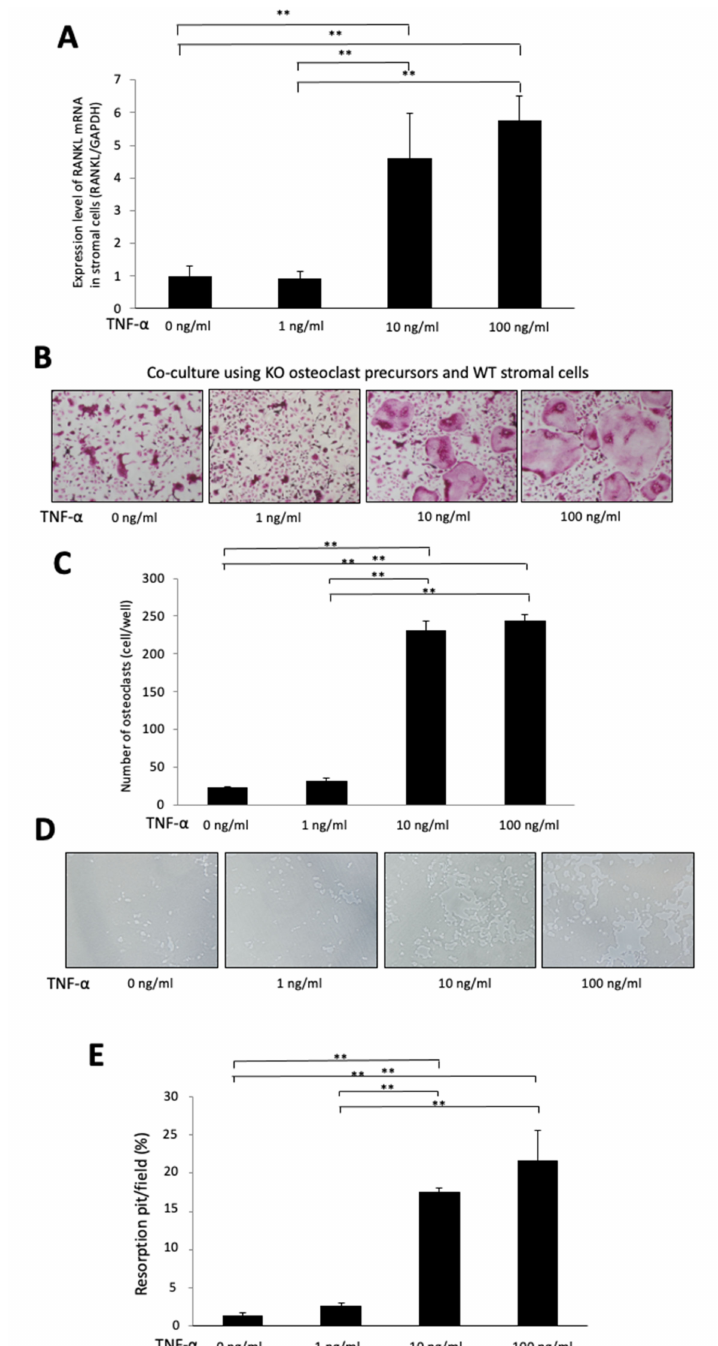
Figure 6. TNF- α induces RANKL expression in WT stromal cells and induced osteoclast formation in a co-culture using KO osteoclast precursors to eliminate the effect of TNF- α on osteoclast formation and WT stromal cells in a dose-dependent manner: ( A ) Real-time RT-PCR analysis of expression levels of RANKL mRNA in WT stromal cells. Total RNA was obtained from WT stromal cells cultured with TNF- α (0, 1, 10 and 100 ng/mL) for 3 days. ( B ) Images of TRAP-positive cells and ( C ) the number of TRAP-positive cells. ( D ) Images of the resorption pits and ( E ) the percentage of resorption pits in co-cultures of WT stromal cells and KO osteoclast precursors cultured with TNF- α (0, 1, 10 and 100 ng/mL) in the present of prostaglandin E2 and 1,25(OH) 2 D 3 for 4 days. The results are presented as the mean ± standard deviation ( n = 4). ** p < 0.01 indicate significant differences, which were analyzed by using the Scheffe